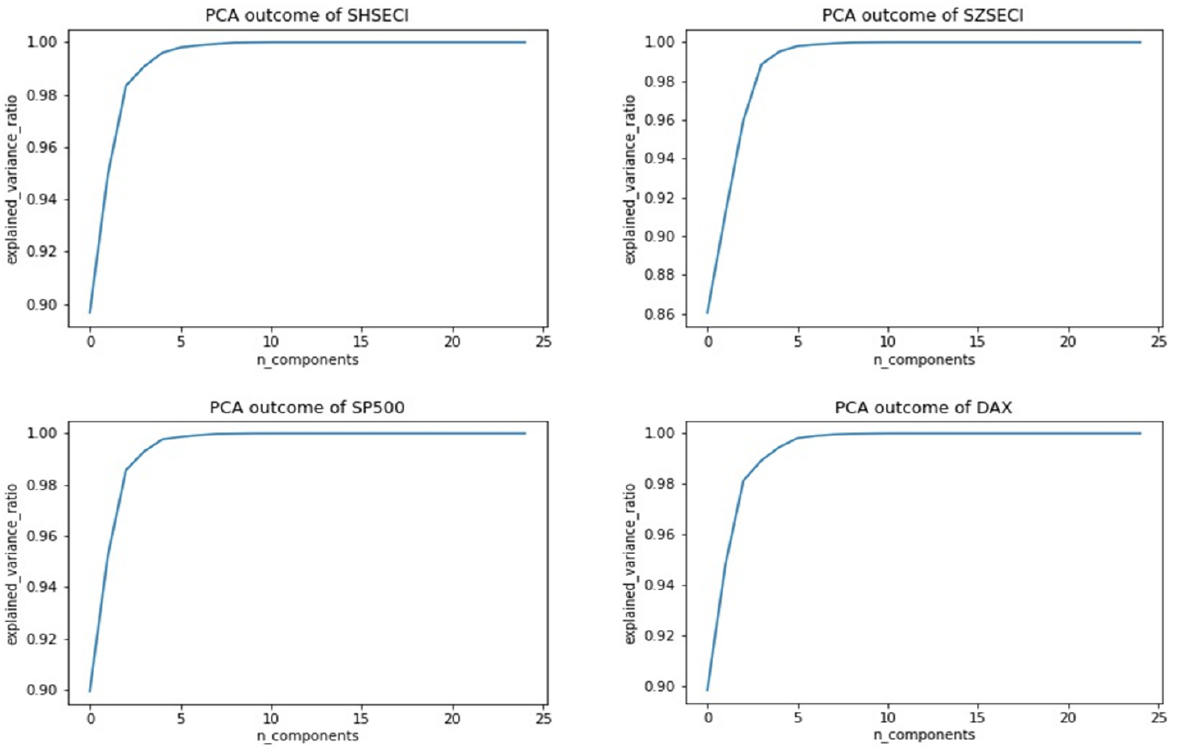
Figure 5 . Outcomes of PCA. Figure 5. Outcomes of Table 2 . Explained variance ratio of four stock indices.